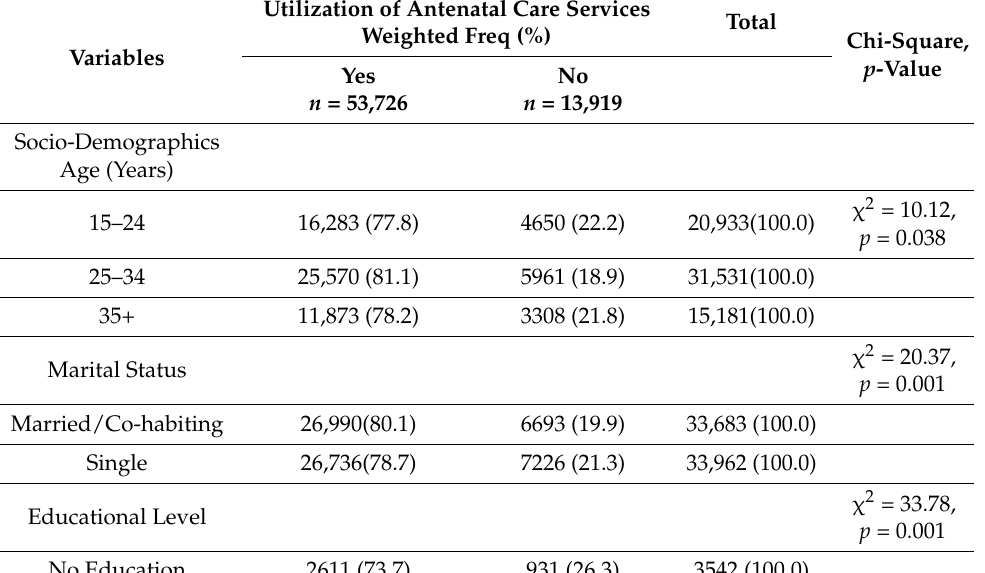
Table 2. Associated factors for utilization of antenatal care services.